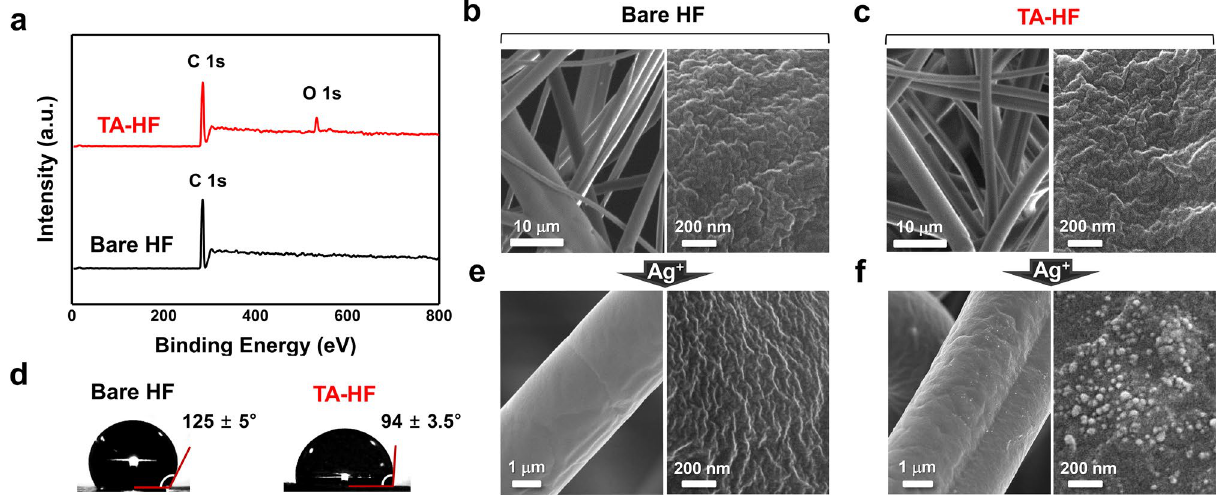
Figure 2. Surface characterization of TA-HF. (a) XPS spectra of TA-HF (top) and bare HF (bottom). (b,c) SEM images showing the surface morphologies of the bare HF (b) and TA-HF (c) . The images on the left are at lower magnification, and the images on the right are at higher magnification. (d) Water contact angle images of the bare HF (left) and TA-HF (right). (e,f) SEM images of the bare HF (e) and TA-HF (f) after silver